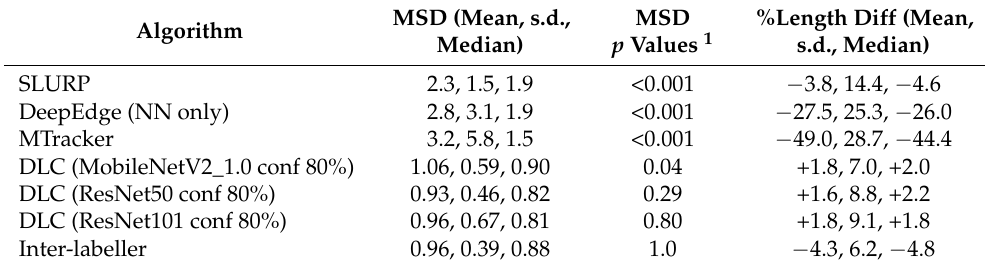
Table 4. Error scores vs. hand contoured (including regions where hand labels had to be guessed at tip and